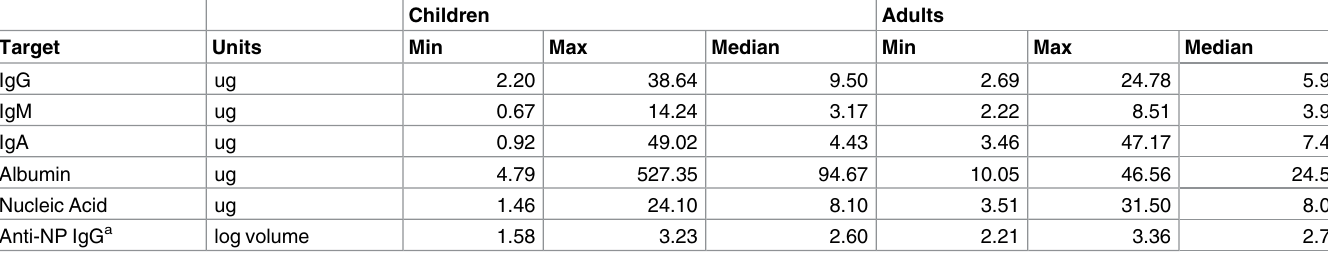
Table 2. Per swab quantities of respiratory sample components in NPS samples from children and adults.